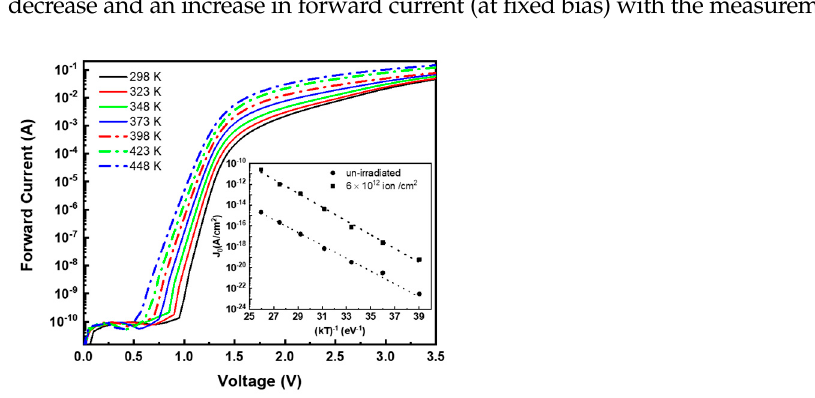
Figure 7. I–V characteristics at different temperatures of the 6.0 × 10 12 cm − 2 irradiated diode. Inset: pre-exponential factor (J 0 ) obtained by the fit of I–V characteristics as a function of 1/kT for the same diode (full squares) and for the un-irradiated diode (full circles).